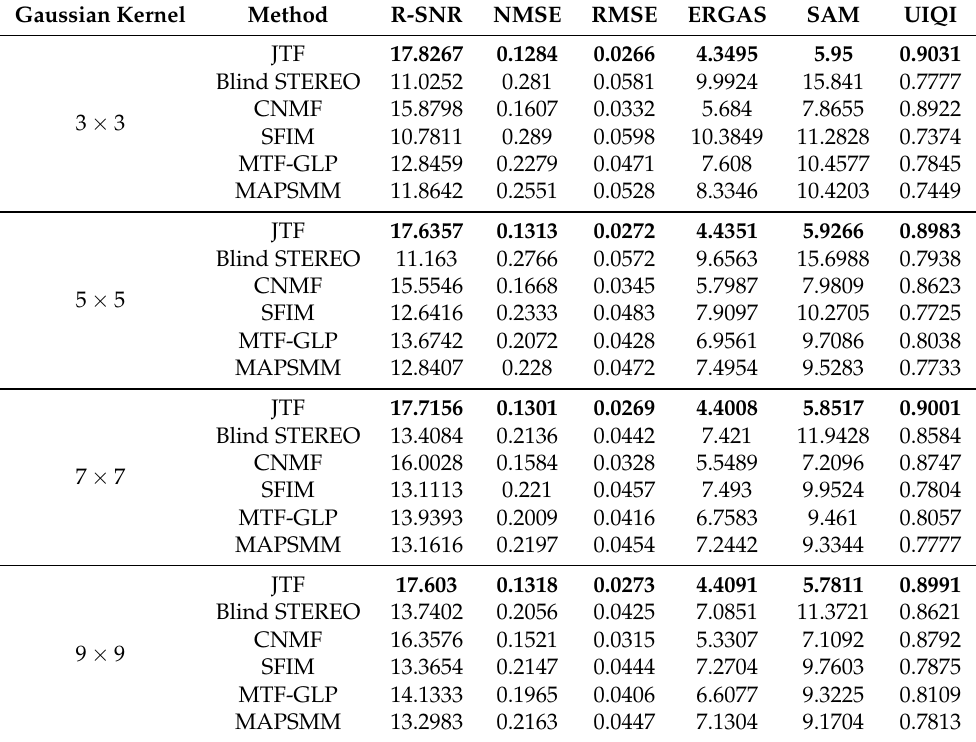
Table 1. Quantitative results of the test methods on Pavia University under the different Gaussian kernels. CNMF, coupled nonnegative matrix factorization; SFIM, smoothing filter based intensity modulation; MTF-GLP, modulation transfer function based generalized Laplacian pyramid; MAPSMM, maximum a posterior estimation with a stochastic mixing